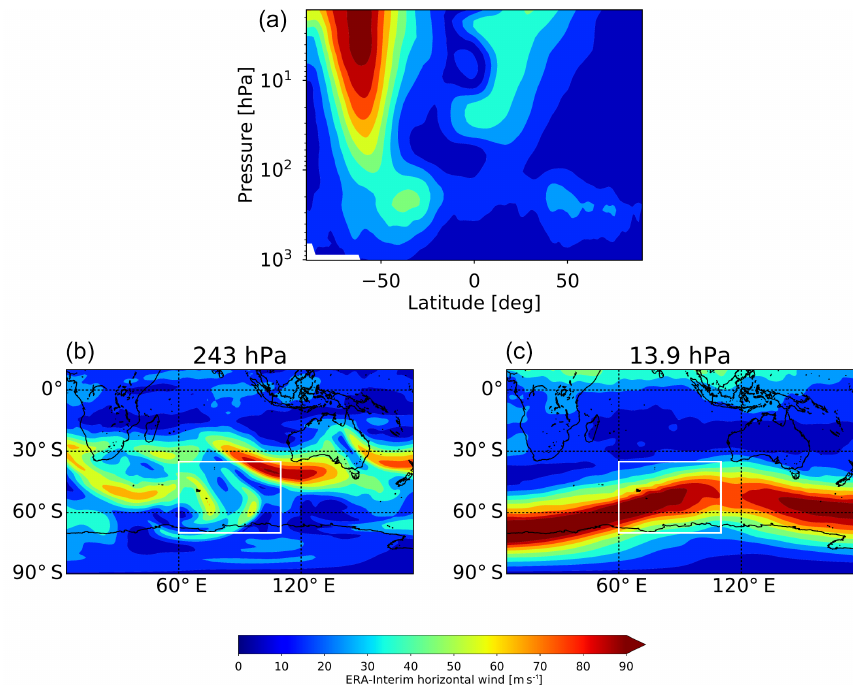
Figure 8. (a) Zonal average of horizontal wind of ERA-Interim for a non-orographic gravity wave event over the southern Indian Ocean on 8 August 2007 at 18:00UTC. (b, c) Horizontal wind maps of ERA-Interim. The white box indicates the region covered in Figs. 6 and 9.